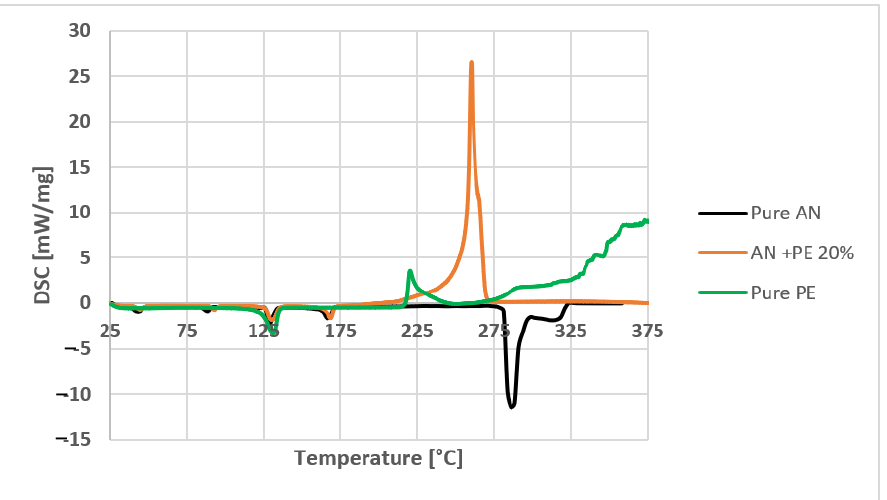
Figure 1. Differential scanning calorimeter (DSC) analysis showing the course of reaction of pure ammonium nitrate (AN), pure polyethylene (PE) and their mixture (containing 20% of the polymer), heat rate 10 °C/min.